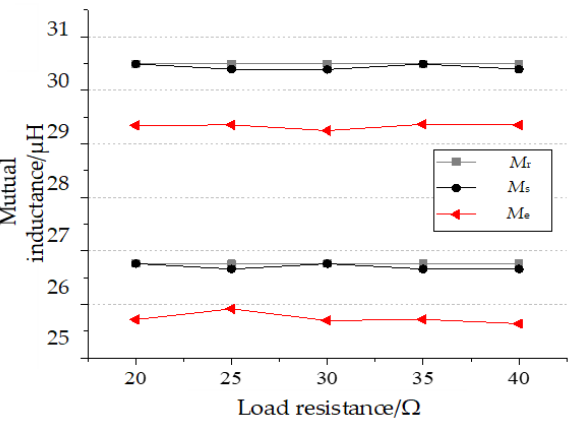
Figure 10. Comparison of mutual inductance identification results under different loads.